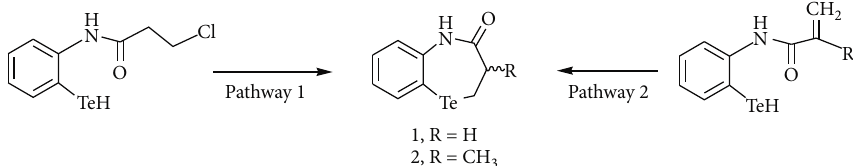
Figure 5: Access to 1,5-tellurazepinones by intramolecular S R � H or CH 3 ).